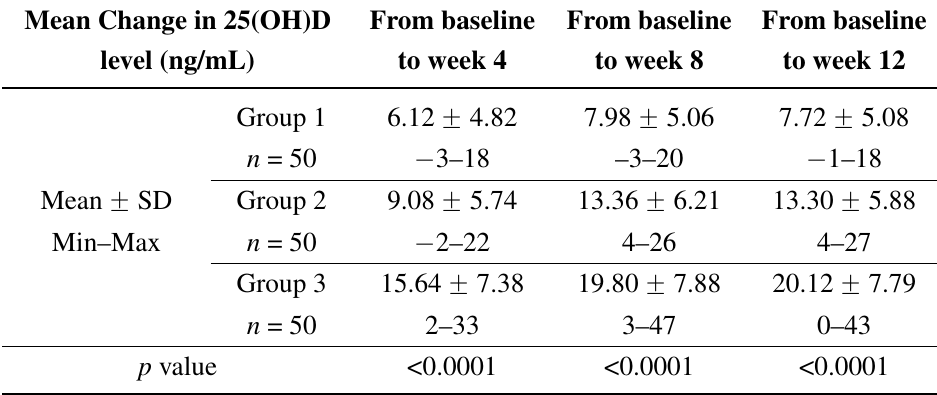
Table 3. Mean change of 25(OH)D (ng/mL) serum concentrations over time.